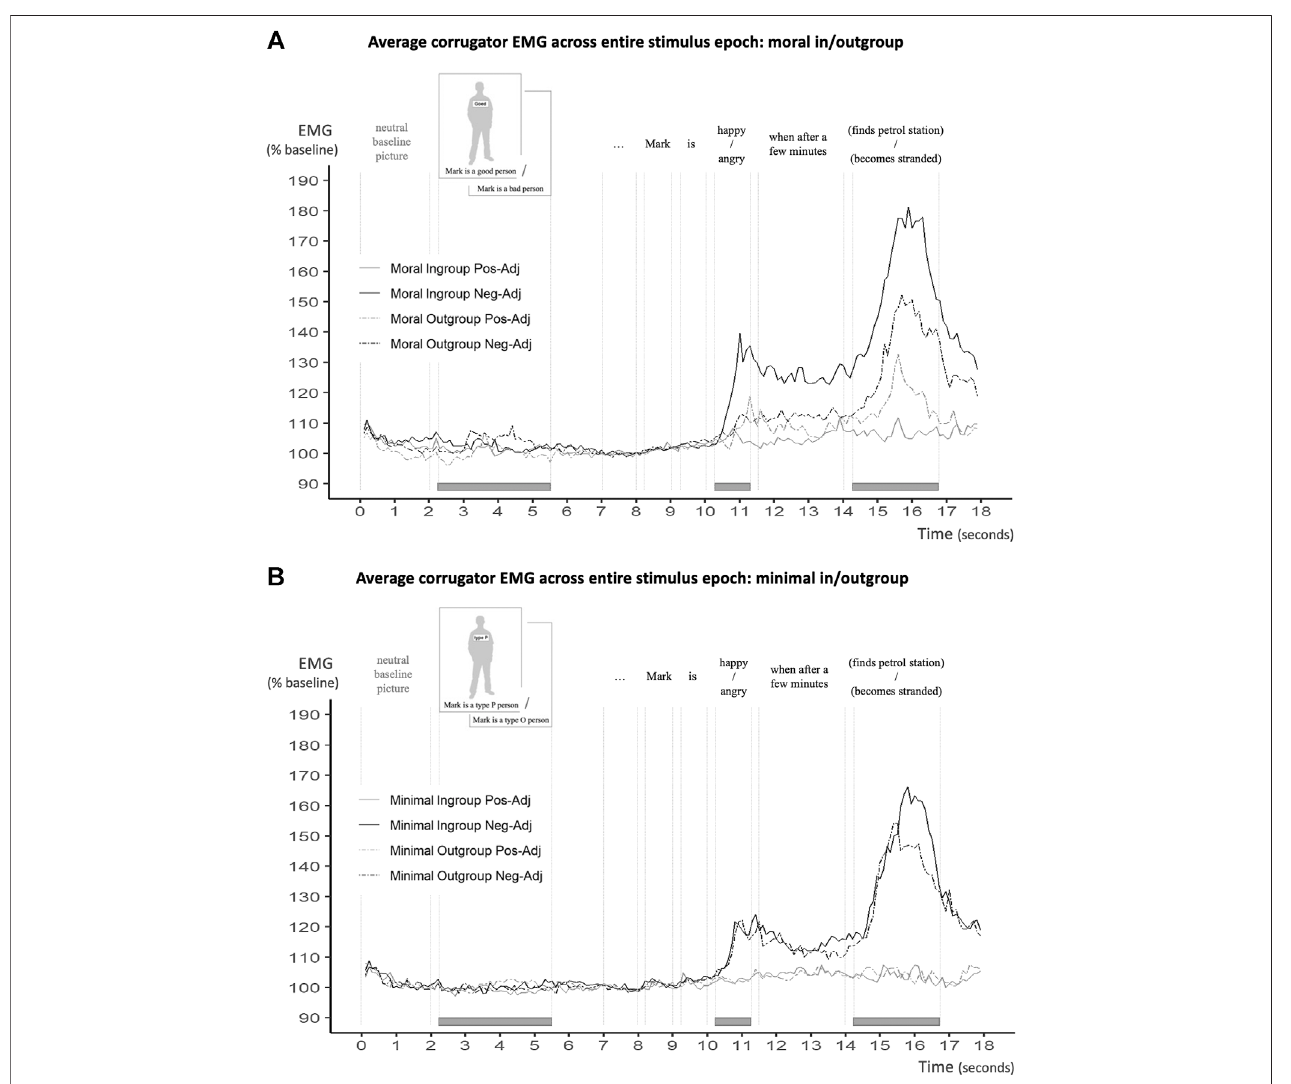
FIGURE 3 | Corrugator EMG across the entire stimulus epoch, for (A) moral and (B) minimal in- and outgroups, together with a (partly abbreviated) example item, the associated stimulus component presentation onsets and offsets (thin vertical lines) and the three critical EMG segments (gray bars). Note that on average, EMG activityinthe fi rsttwosecondsisabove100%becausethevaluesonwhichthebaselinevalueisbasedmaybeasubsetofalldatapointsinthis2-sinterval(seeMethods for EMG baselining procedure).